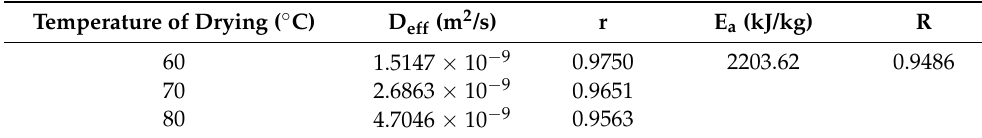
Figure 8 . Relationship between effective moisture diffusivity and reciprocal absolute temperature. 3.5. Energy Utilization in The Convective Solar Dryer 3.5.1. Total Energy Utilization of The Forced Convection Solar Dryer The total energy used by the convective solar dryer to dry the Arbutus unedo L. fruit samples at different temperatures is presented in Figure 9.